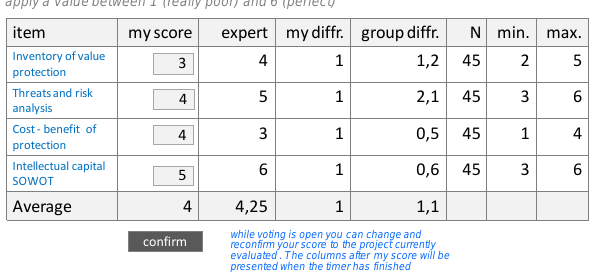
Figure 5. Items to evaluate by students in “guess the score”